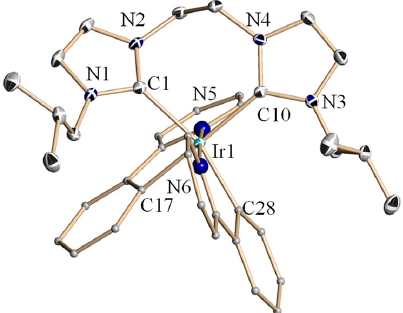
Figure 6. Molecule structure of 4f in the solid state. Hydrogen atoms, anions and a disorder of one side arm are omitted and ppy ligands are simplified for clarity. Selected distances [Å] and angles [°]: Ir-C1 2.145(2), Ir-C10 2.134(2), Ir-C17 2.069(2), Ir-C28 2.043(2), Ir-N5 2.065(2), Ir-N6 2.044(2), C28-